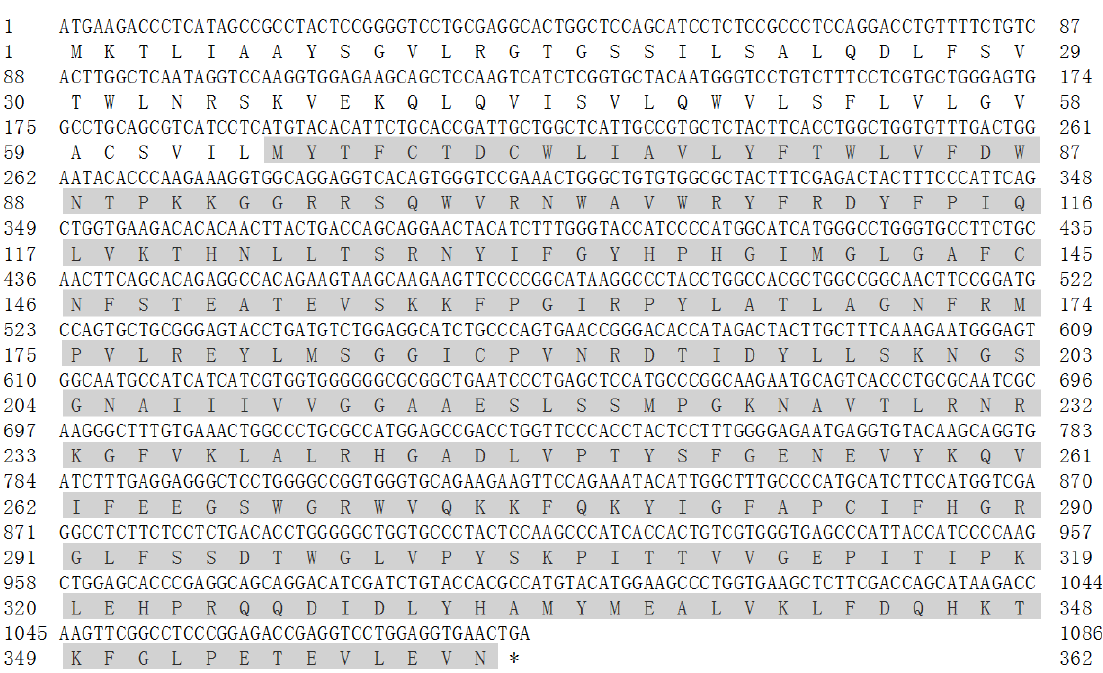
Figure 2. The CDS of buffalo DGAT2 and its encoded amino acid sequence. Shaded area indicates DAGAT conserved domain (AA65-361).